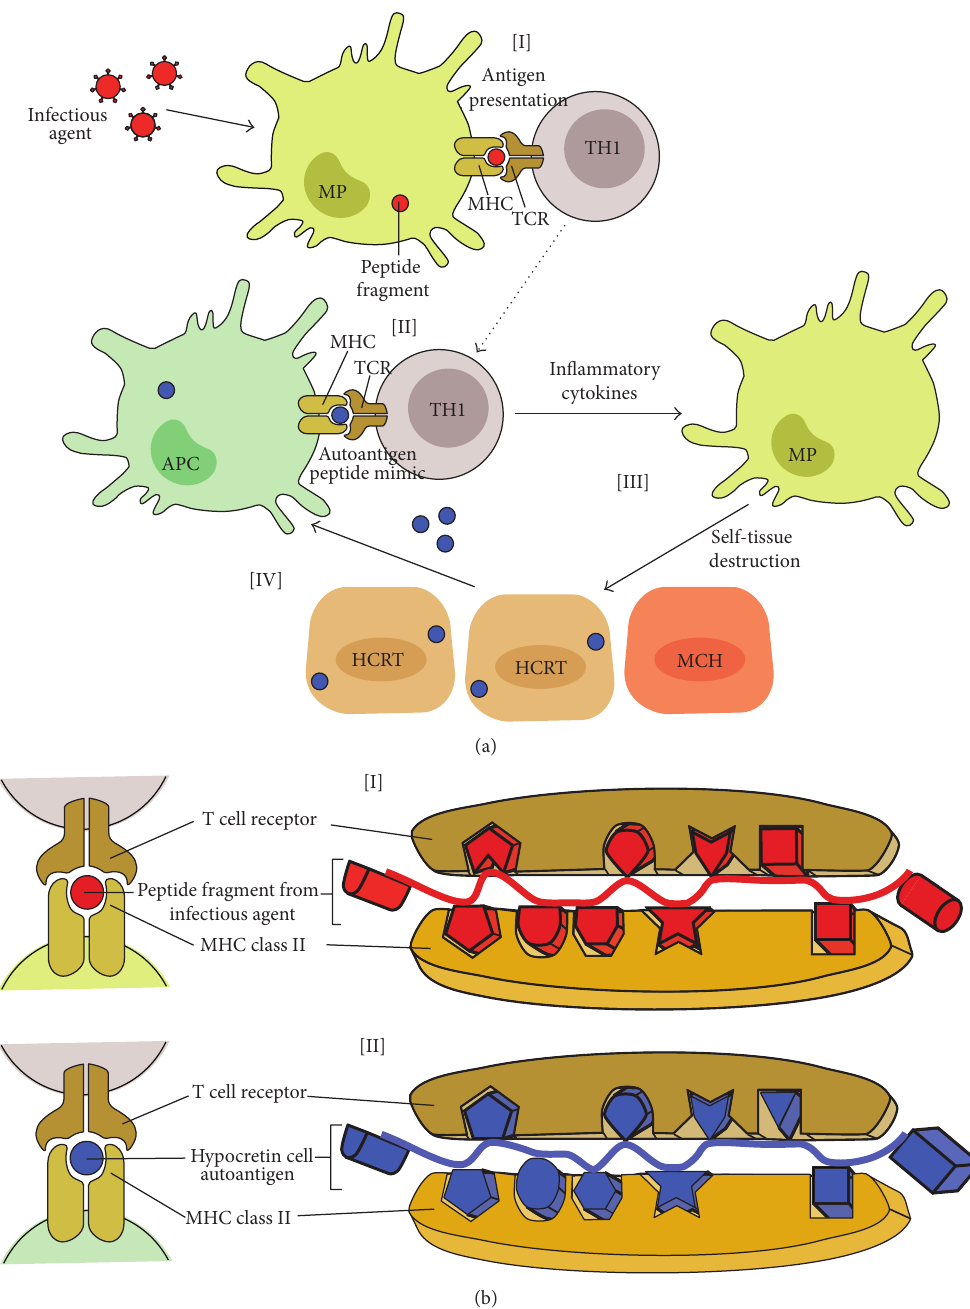
Figure 1: (a) Molecular mimicry describes the activation of cross-reactive TH1 cells that recognize both the microbial epitope [I] and the autoantigen [II]. Activation of the cross-reactive T cells results in the release of cytokines and chemokines [III] that recruit and activate monocytes and macrophages, which mediate self-tissue damage. The subsequent release of self-tissue antigens and their uptake by APCs perpetuates the autoimmune disease [IV]. (b) Molecular mimicry at the MHC/TCR synapses level. Molecular mimicry between infectious agents (H1N1 and/or streptococcus pyogenes) and hypocretin neuron autoantigens. Sequence and structural homology between foreign [I] andself-peptides[II]arerequiredformolecularmimicrytooccur.TheMHCbindinggrooveselectsthepeptidefragmentwithaspecificamino acid sequence in the context of DQA1 ∗ 01:02-DQB1 ∗ 06:02. The TCR recognizes a presented peptide with a specific amino acid sequence [I and II]. Activated CD4 + T cells cross-react and recognize hypocretin neuron autoantigens as foreign molecules, prompting an autoimmune response against hypocretin neurons